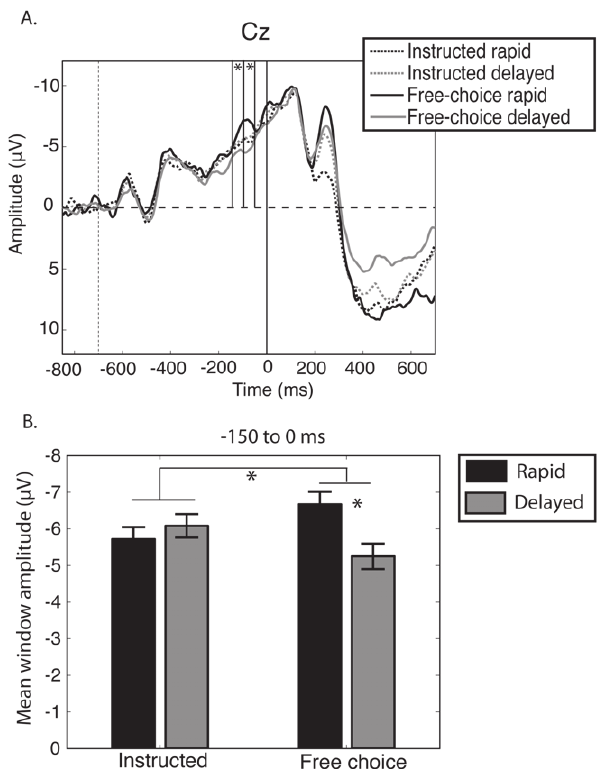
Figure 2. ERPs time locked to the instruction cue A. Averaged CNV amplitude in electrode Cz for the four main conditions, time locked to the appearance of the instruction cue (time 0 corresponds to the onset of the instruction cue). Note the difference in CNV amplitude between two free-choice rapid and delayed trials (solid lines), but no difference in CNV amplitude between instructed choice rapid and delayed trials (dashed lines). Asterisks indicate a significant ANOVA interaction ( F test, p , 0.05, uncorrected). Vertical dashed line at 2 700 ms indicates onset of warning signal and the end of baseline period ( 2 850 to 2 700 ms). B. mean CNV amplitudes for the time window between 2 150 and 0 ms electrode Cz. Asterisk shows a significant difference (t-test, p , 0.05, two tails,